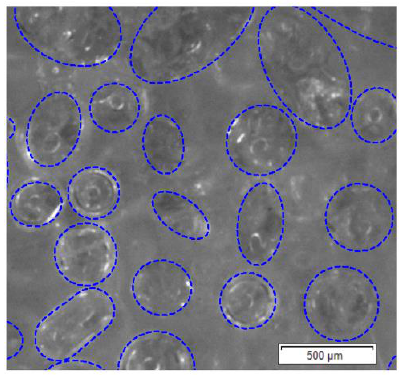
Figure 4. The reinforcing particles in the region of interest behind the speckle pattern.